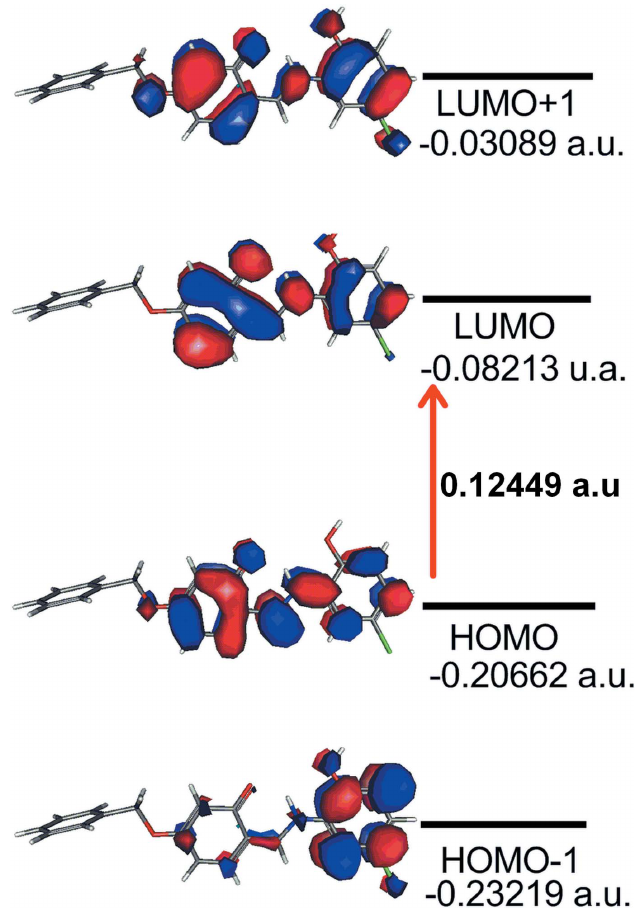
Figure 9 Electron distribution in the HOMO-1, HOMO, LUMO and LUMO-1 energy levels for